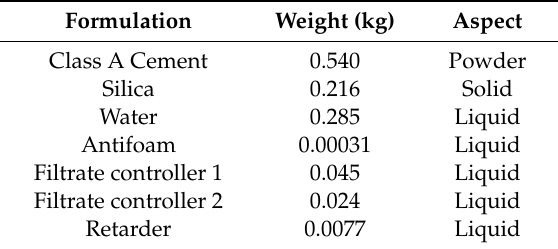
Table 2. Composition of the cement